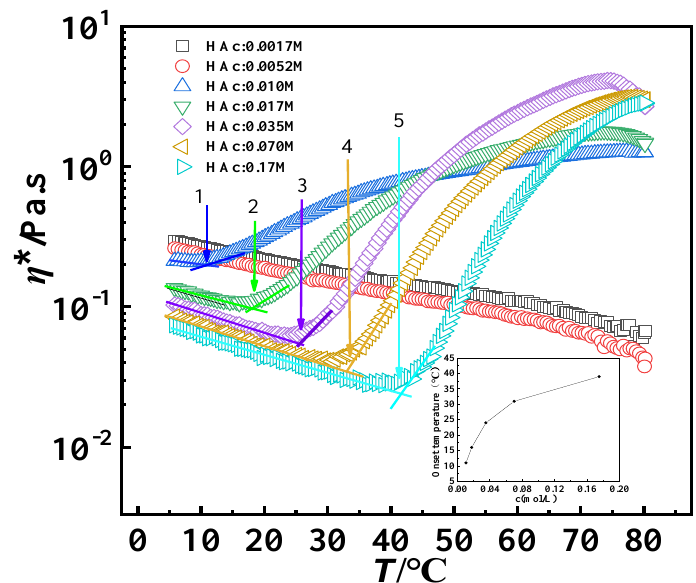
Figure 7. Influence of HAc concentration on thermo − thickening for the GPAM aqueous solution with 10 mg / mL concentration. Inset displays the relationship between onset temperature and concentration of HAc in the 10 mg / mL GPAM aqueous solution. The strain is 0.2% and the oscillatory frequency is 6.283 rad · s − 1 . The heating rate of the samples is 5 ◦ C /